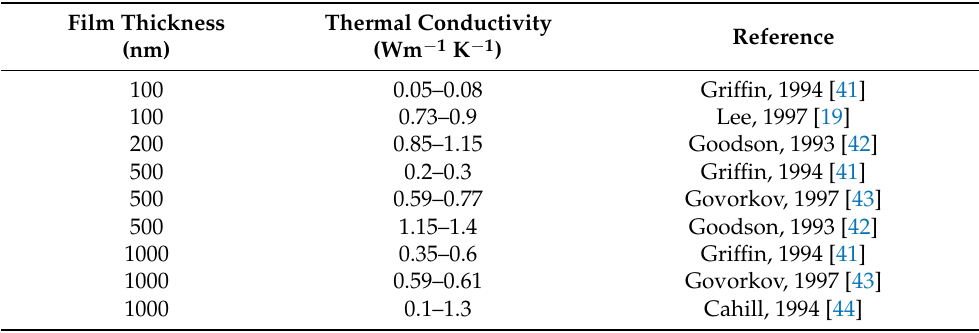
Table 2. Literature values of the thermal conductivity of silicon dioxide for different film thicknesses. The last 3 rows sum up all shown references.